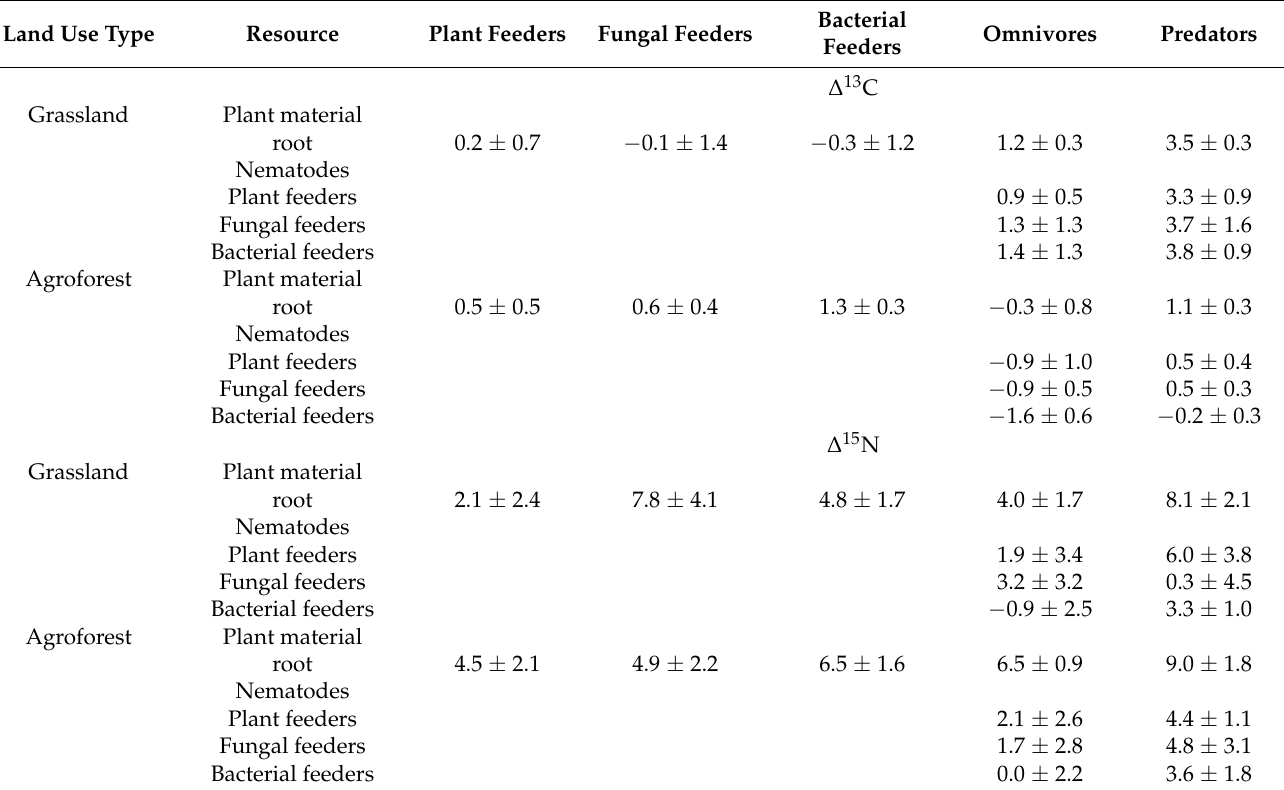
Table 2. Isotopic fractionation of 13 C [ ∆ 13 C in‰ ± s.d.] and 15 N stable isotopes [ ∆ 15 N in‰ ± s.d] between roots as dominant resource and the different trophic groups of nematodes in the micro-food web of a grassland and agroforest soil.